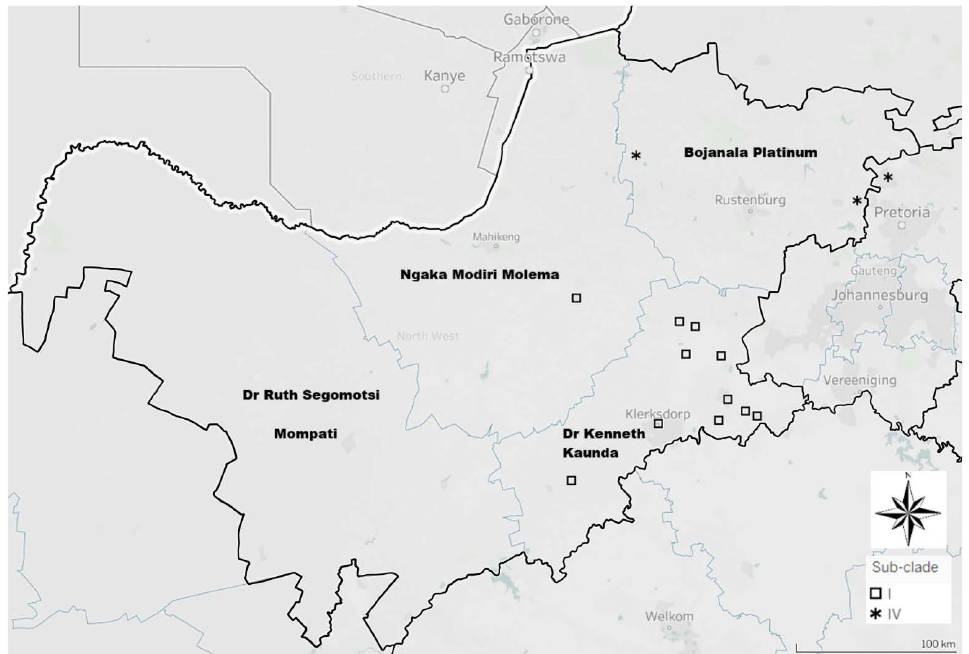
Figure 4. Geographic distribution for each the RABV sequences in sub-clades B-I and B-IV of Clade B. The geographical grouping of the remainder of the sub-clades (B-II, B-III) was more indistinct (compared to the above) and overlapped throughout the eastern half of the NW Province (Figure 3). Sub-clade B-II consisted of RABV sequences collected from a caprine and canine ( n = 2) sample that were from the parts of the NW Province bordering the GP Province. Sub-clade B-III consisted of RABV sequences collected from a bovine, an aardwolf, a black-backed jackal, canine ( n = 2), and an unspecified jackal